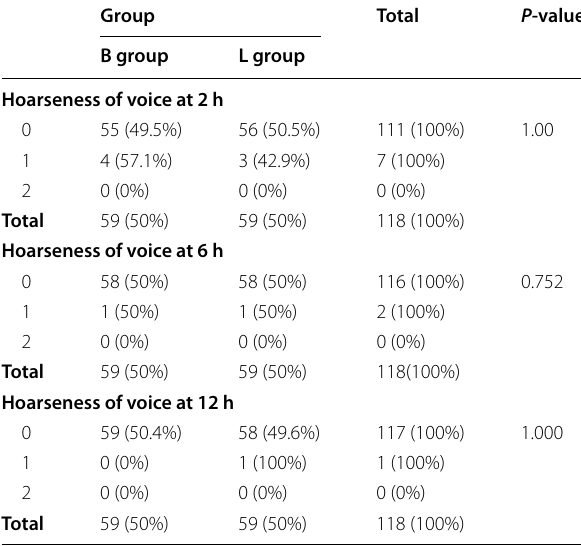
Table 5 Significance of hoarseness of voice at the end of 2, 6, and 12